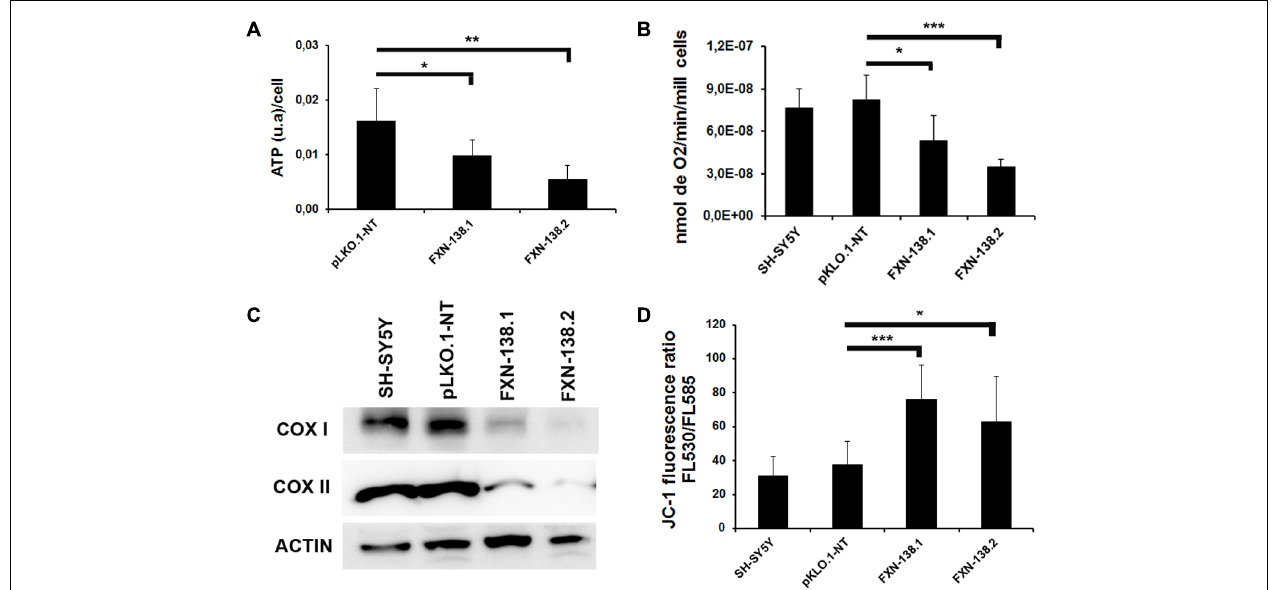
FIGURE 3 |Alterations in mitochondrial bioenergetics in frataxin-deficient cells. (A) ATP synthesis was measured in all the clones and was reduced in frataxin-deficient cells. Error bars indicate the standard deviation (SD) of at least three independent assays. Student’s t -test, FXN-138.1 p = 0.034, FXN-138.2 p = 0.003 versus pLKO.1-NT. (B) Oxygen consumption was assessed using a Clark-type oxygen electrode. Oxygen consumption was lower in clones deficient in frataxin. Student’s t -test, FXN-138.1 p = 0.035, FXN-138.2 p = 0.00004 versus pLKO.1-NT. (C) Western blot analysis of Complex IV of mitochondrial extracts from all the cells